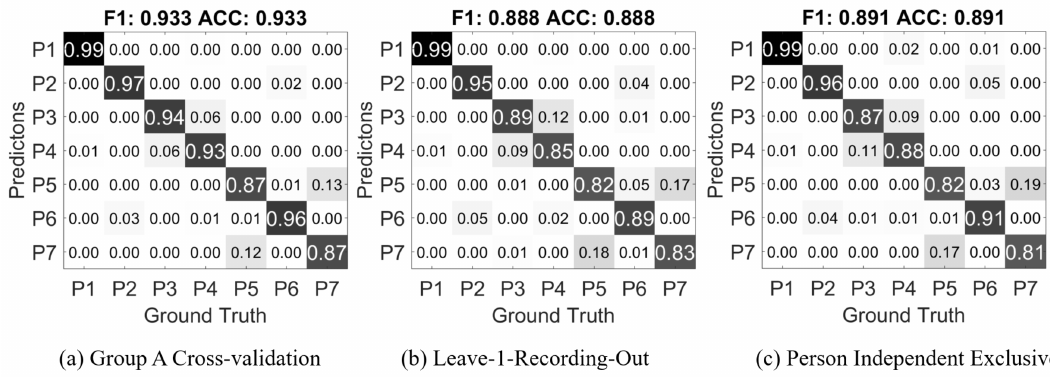
Figure 9. Confusion matrix of the cross-validation result on Group A